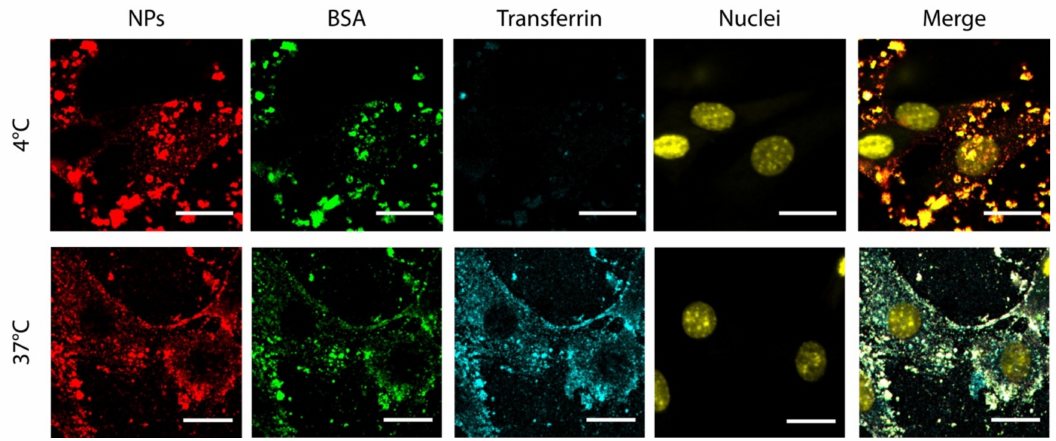
Figure 3. Representative confocal images of BSA PEI NPs internalization in cells at 4 and 37 ◦ C. Scale bars: 20 µ